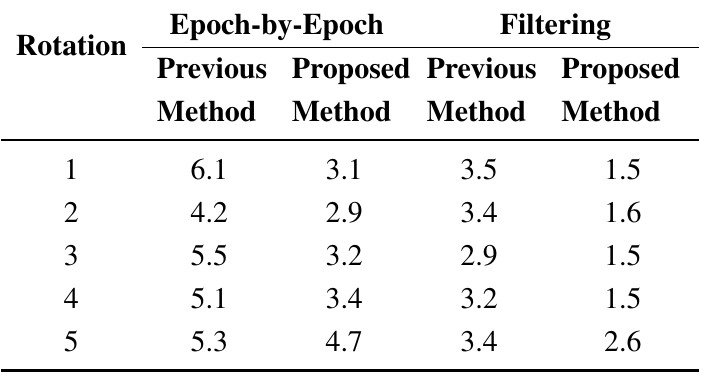
Table 7. 3D position root mean square (RMSE) (mm) for kinematic data (20-m baseline).